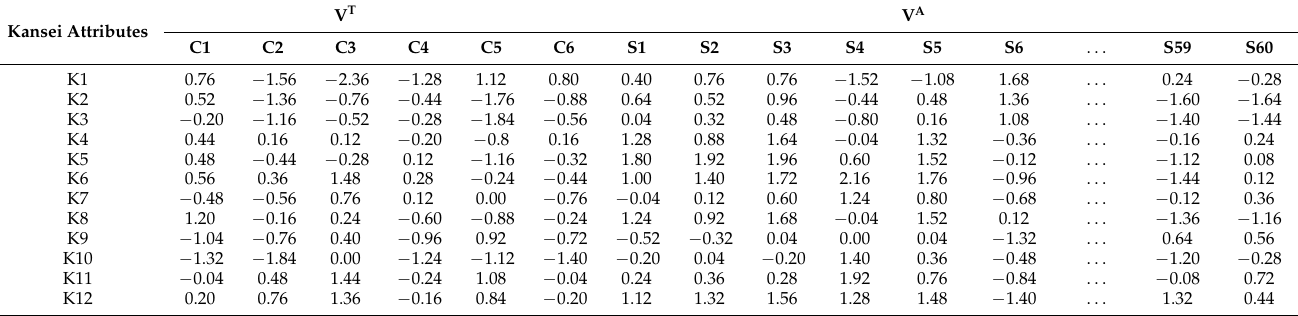
Table 5. Final evaluation scores for target feeling and acquired feeling.